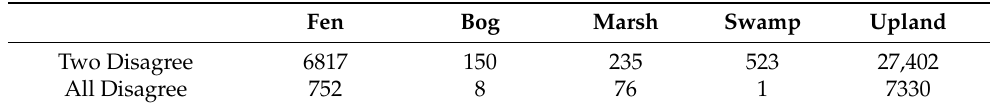
Table 10. Land-cover breakdown of the misclassified pixels where two classifiers disagreed or all